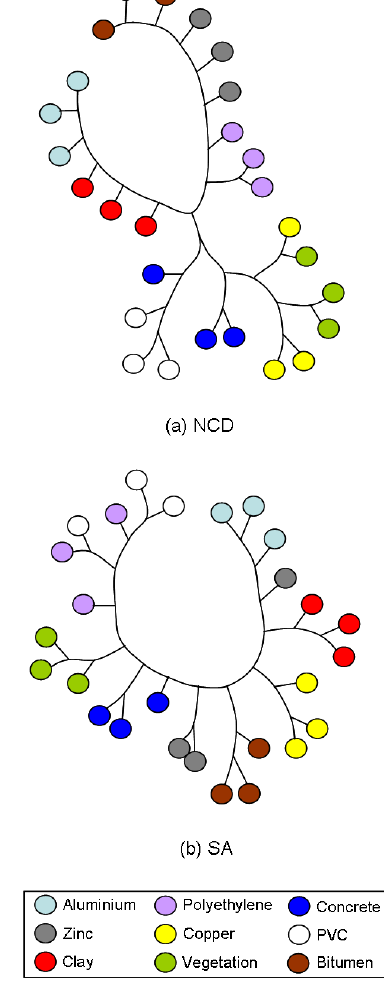
Figure 6: Hierarchical clusterings for 27 pixels collected on roofs of 9 different materials. Results for NCD and Spectral Angle